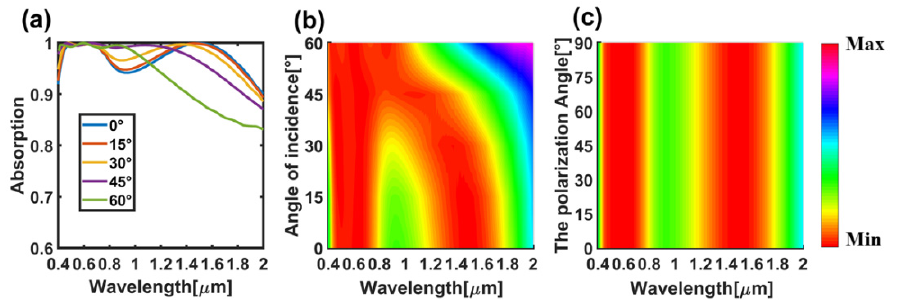
Figure 7. Absorption efficiency of different incident angles and polarization angles. ( a ) The absorption efficiency diagram when the incident angle is changed; ( b ) The electric field diagram when the incident angle is changed; ( c ) The electric field diagram when the polarization angle is changed.